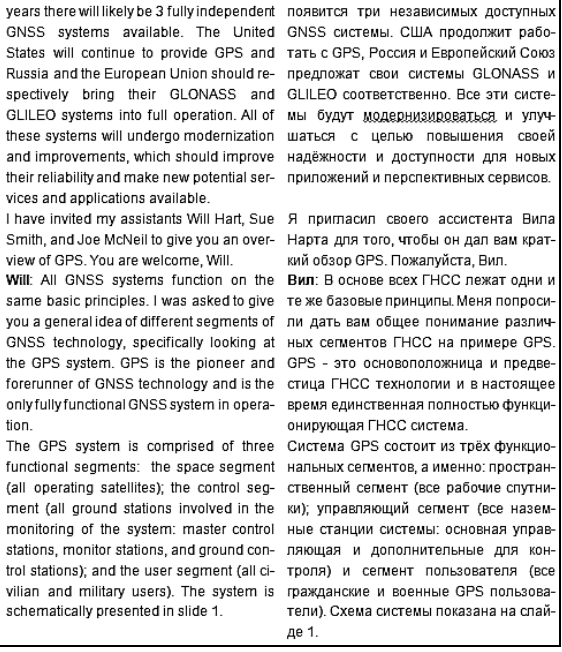
Figure 1. A part of a GE and ESP RP with simultaneous translation into a native language